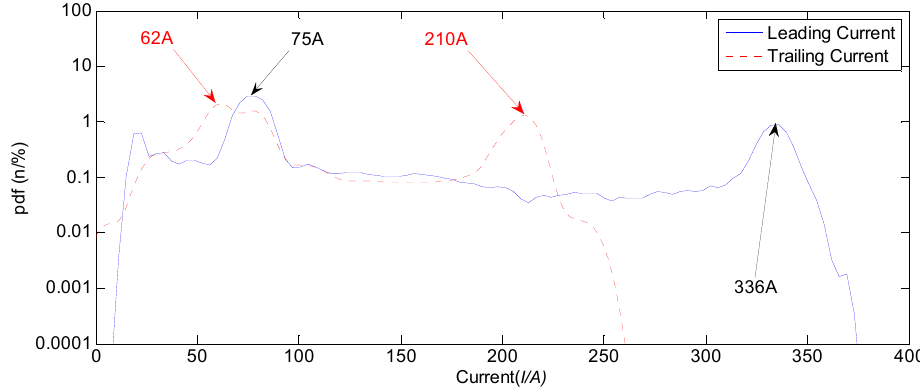
Figure 6. Probability density function (pdf) figure of experiment 1.